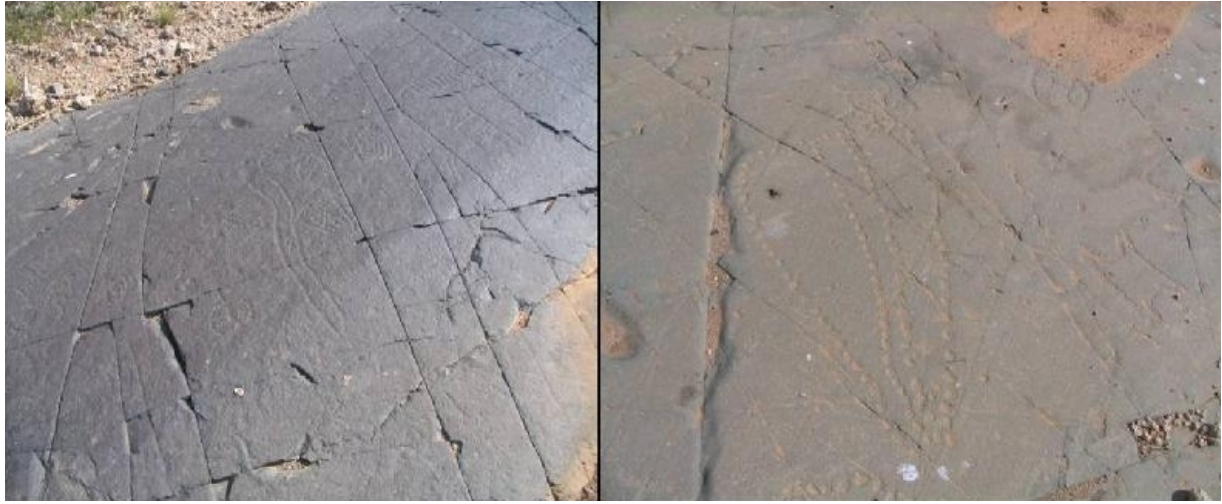
Figure 2. Engravings reminiscent of snakes on an andesite river bed at Dreikopseiland, Northern Cape Province. Photo: Chris Low, personal